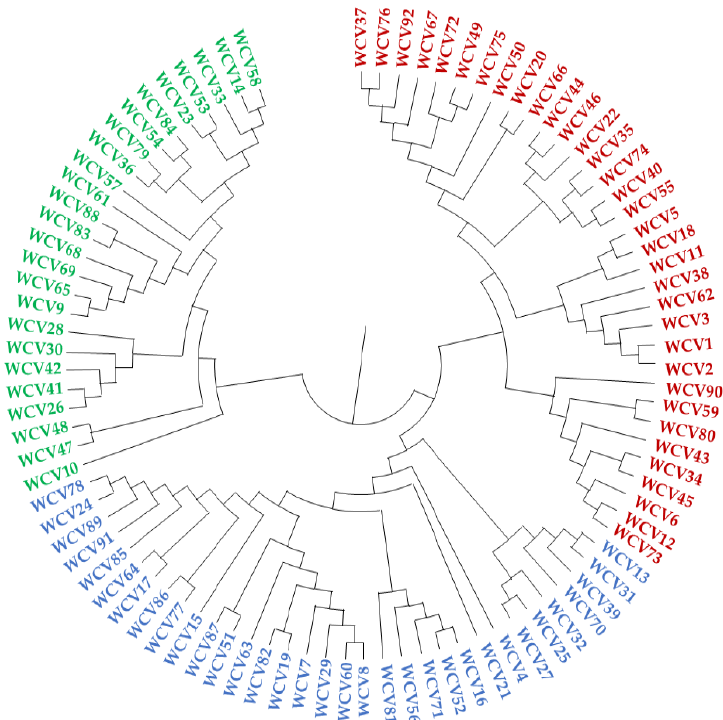
Figure 3. Dendrogram showing the morphological diversity among 92 WCVs based on morphological traits .